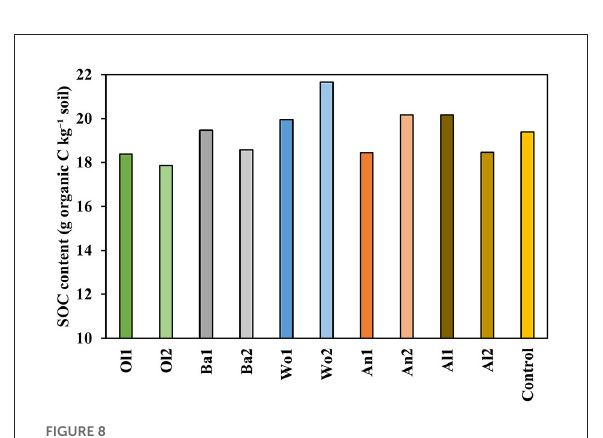
FIGURE8 SOC content measured at the end of the